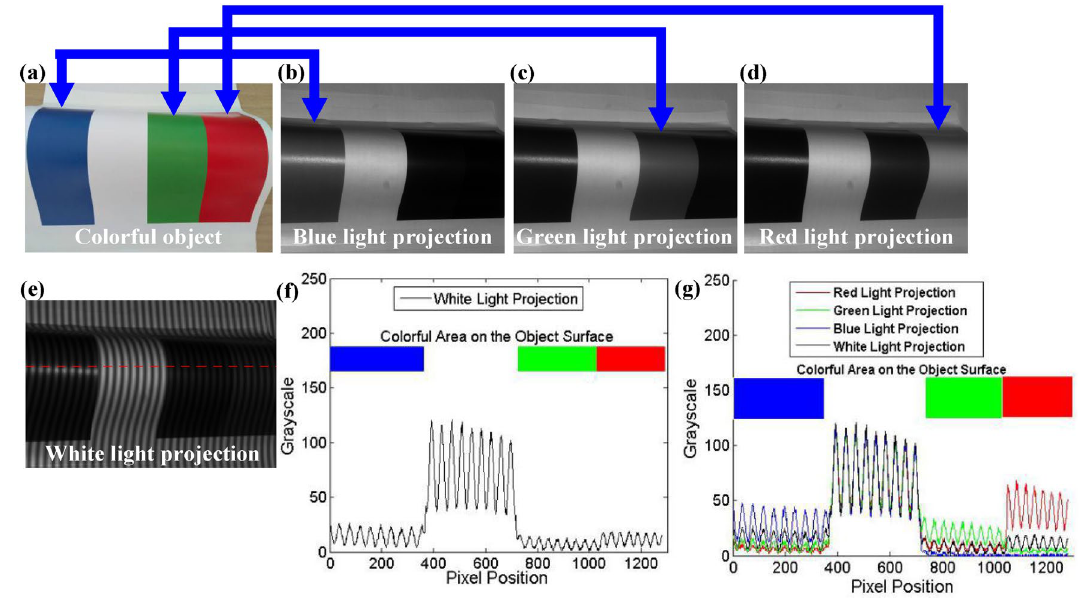
Figure 6. Pixel-level color. ( a ) Colorful object. ( b ) The captured image by a B/W camera based on blue light projection. ( c ) The captured image by a B/W camera based on green light projection. ( d ) The captured image by a B/W camera based on red light projection. ( e ) The captured fringe pattern by a B/W camera based on white light projection. ( f ) The grayscale of the red dotted line in ( e ). ( g ) The grayscale of the red dotted line in ( e ) based on different light